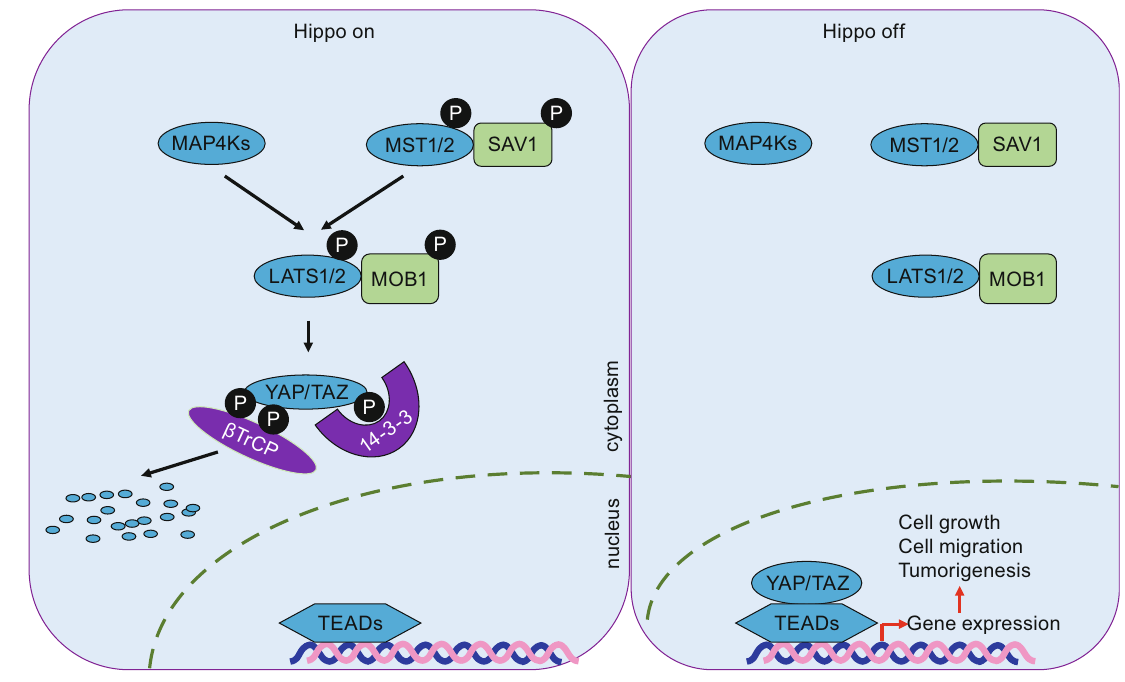
Figure 1. The core of the Hippo signaling pathway. The core components of the Hippo pathway comprise a kinase cascade and a transcriptional activation module. When the Hippo pathway is activated, mammalian STE20-like 1/2 (MST1/2) phosphorylate and form complex with Salvador 1 (SAV1). MST1/2 phosphorylate and activate large tumor suppressor 1/2 (LATS1/2) and Mob1 homolog (MOB1). Beside MST1/2, MAP4K family members could directly phosphorylate LATS1/2 as well. Two homologues transcriptional coactivator yes-associated protein (YAP) and WW domain-containing transcription factor (TAZ) are phosphorylated and inactivated by LATS1/2 via cytoplasmic retardation by 14-3-3 or degradation by SCF/CRL1( β -TrCP) E3 ligase. When the Hippo pathway is inactivated, MST1/2 and LATS1/2 are dephosphorylated and inactivated, resulting in the dephosphorylation and nuclear localization of YAP/TAZ. As transcriptional coactivators, the nuclear YAP/TAZ bind to and activate TEA domain family members 1 – 4 (TEAD1 – 4), leading to the transcription of genes relating to cell proliferation, migration, and